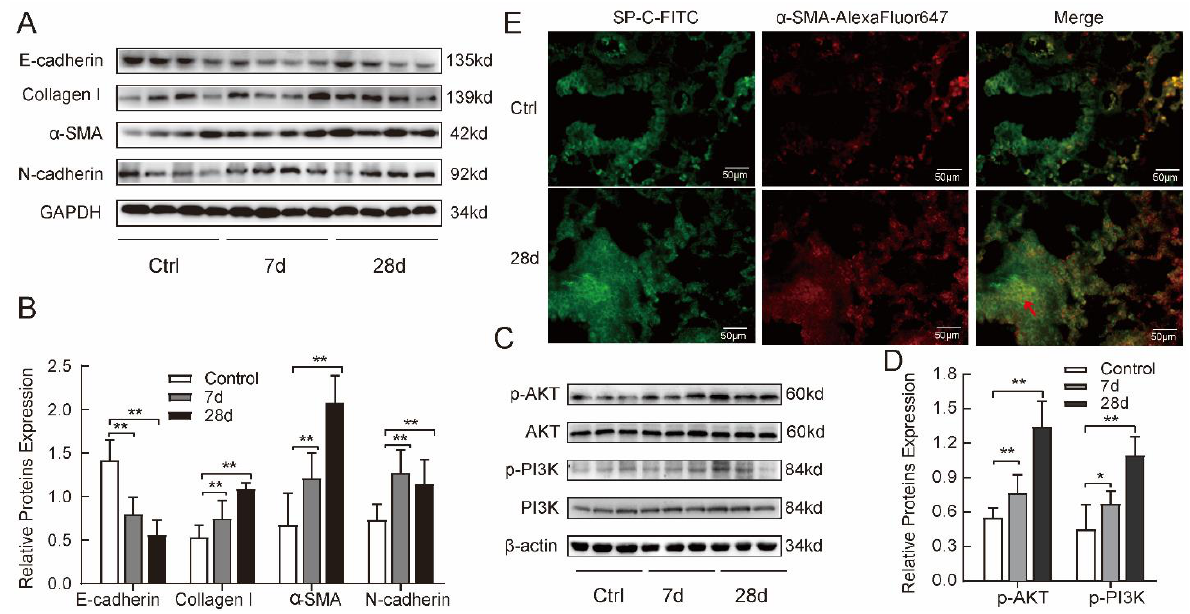
Figure 2. Silica-induced fibrosis was associated with upregulation of the PI3K/AKT pathway in mice. ( A , B ) Silica suppressed the expression of E-cadherin protein while enhancing the expression of collagen I , α -SMA, and N-cadherin proteins detected with Western blotting in 7-d and 28-d groups, compared with control group. ( C , D ) Silica activated phosphorylation of the PI3K/AKT signal pathway in model lung tissues detected with Western blotting assay. ( E ) Silica-induced SP-C (green-fluorescent) and α -SMA (red-fluorescent) co-localized proteins in the 28-d model lungs with double immunofluorescent staining. Red arrow indicates co-localization (yellow color). One-way analysis of variance. * p < 0.05, ** p < 0.01 versus control group. The results are shown as mean ± SD, n = 8.